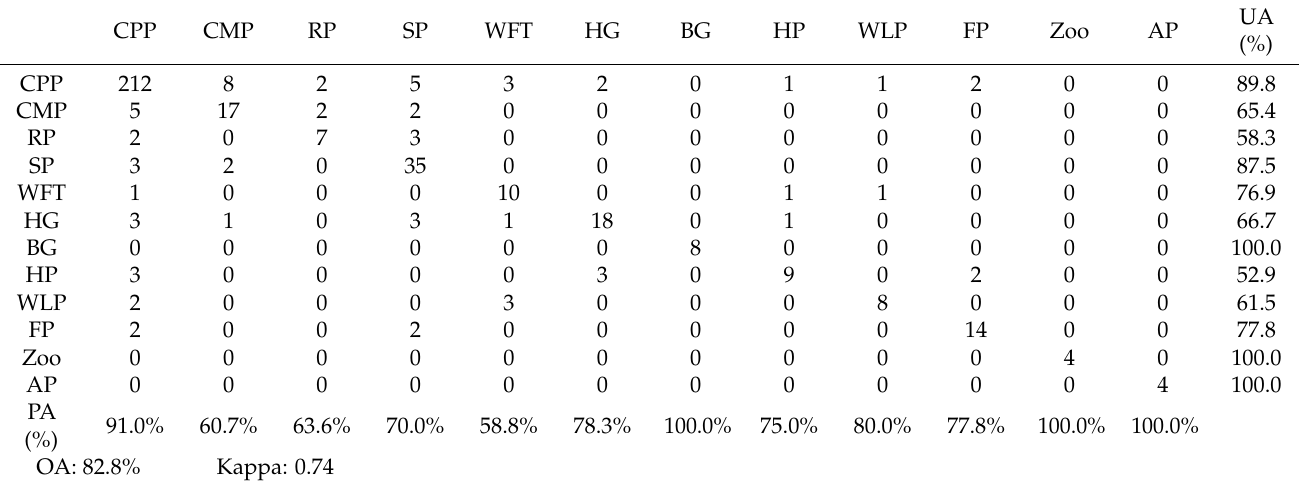
Table 5. The confusion matrix of urban park mapping